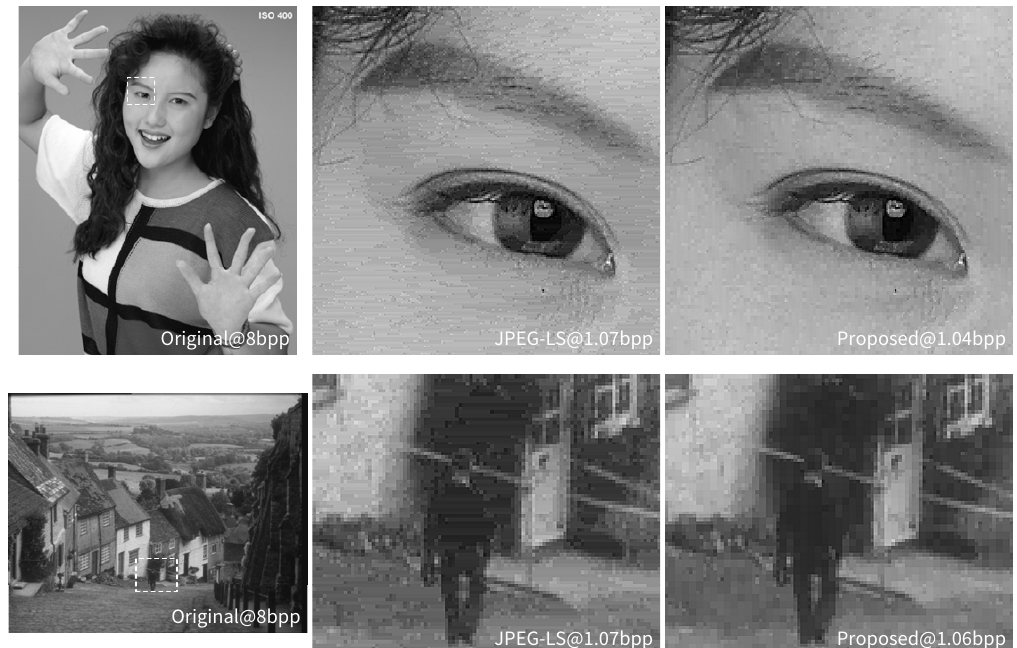
Figure 26. Visual quality of images compressed by JPEG-LS and the proposed JND-based perceptual codec at closely comparable bit rates: top and bottom, WOMAN and GOLD image; and left to right, original image, selected section compressed by JPEG-LS, and same section compressed by the perceptual